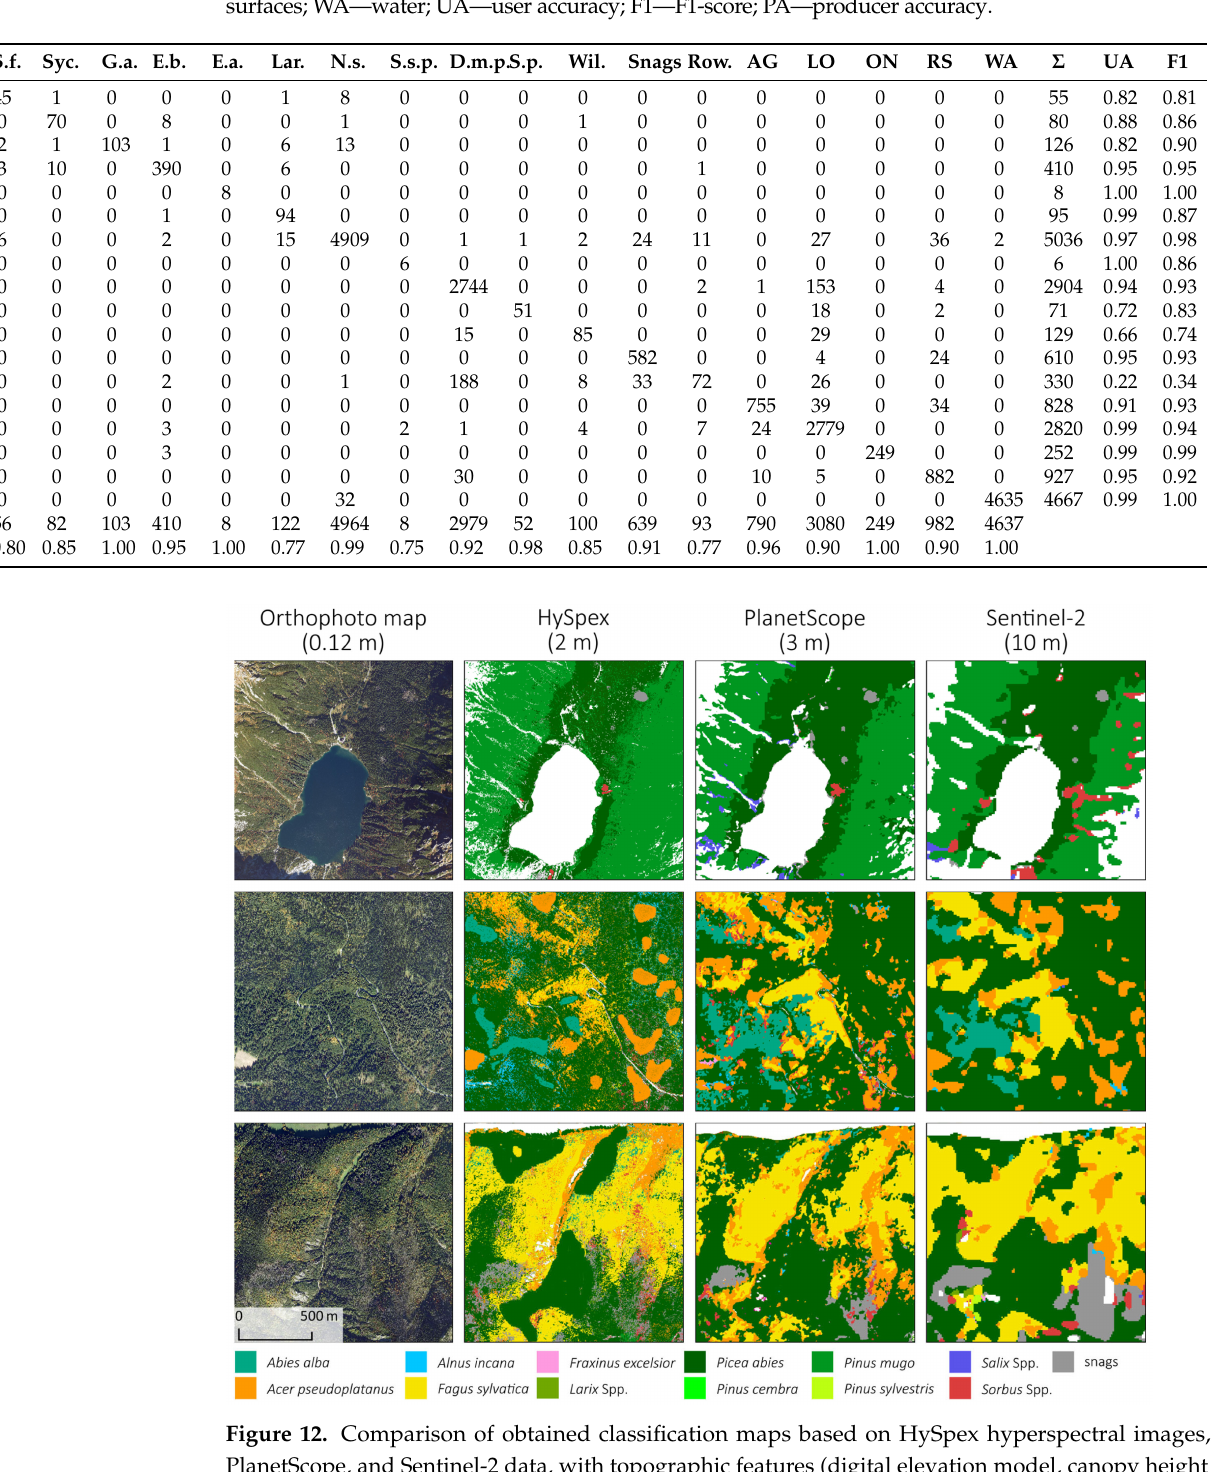
Table 5. Error matrix of obtained Sentinel-2, with topographic features and Random Forest classification results presented on Figure 11. S.f.—silver fir ( Abies alba ); Syc.—sycamore ( Acer pseudoplatanus ); G.a.—grey alder ( Alnus incana ); E.b.—European beech ( Fagus sylvatica ); E.a.—European ash ( Fraxinus excelsior ); Lar.— larch ( Larix spp.); N.s.—Norway spruce ( Picea abies ); S.s.p.—Swiss stone pine ( Pinus cembra ); D.m.p.—dwarf